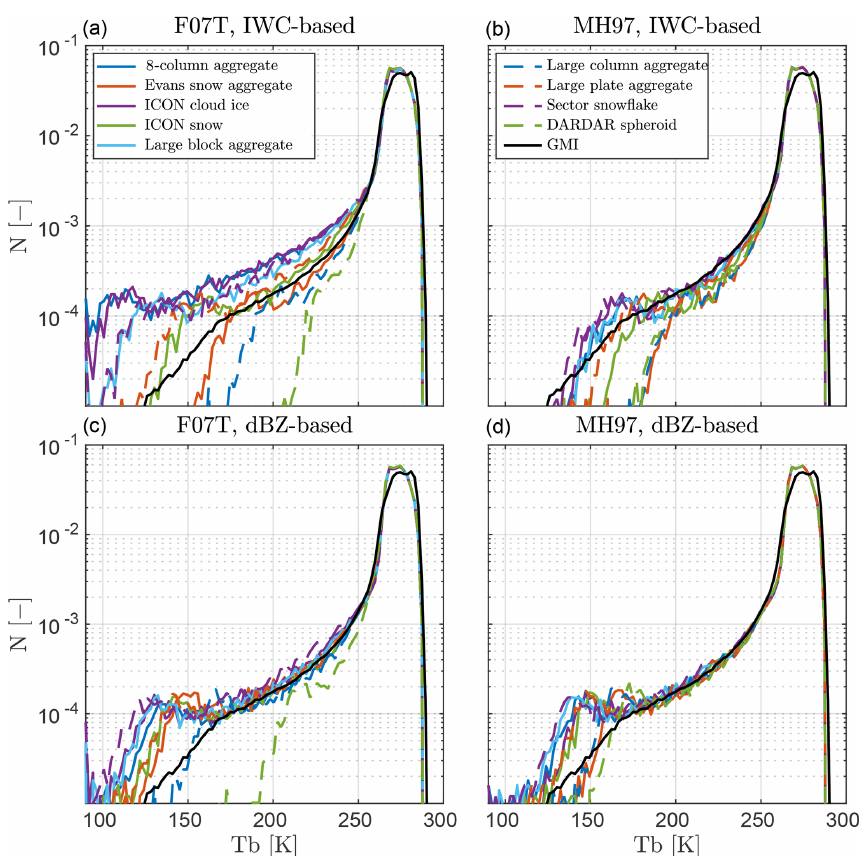
Figure 10. Occurrence frequencies of TBs at 190.31GHz assuming various particle models. Curves are normalized to have unit area. The different coloured lines represent the particle type used in the forward simulation. The black line is derived from GMI measurements. The modes used are IWC-based (a, b) and dBZ-based (c, d) . The PSDs are MH97 (a, c) and F07T (b, d) .